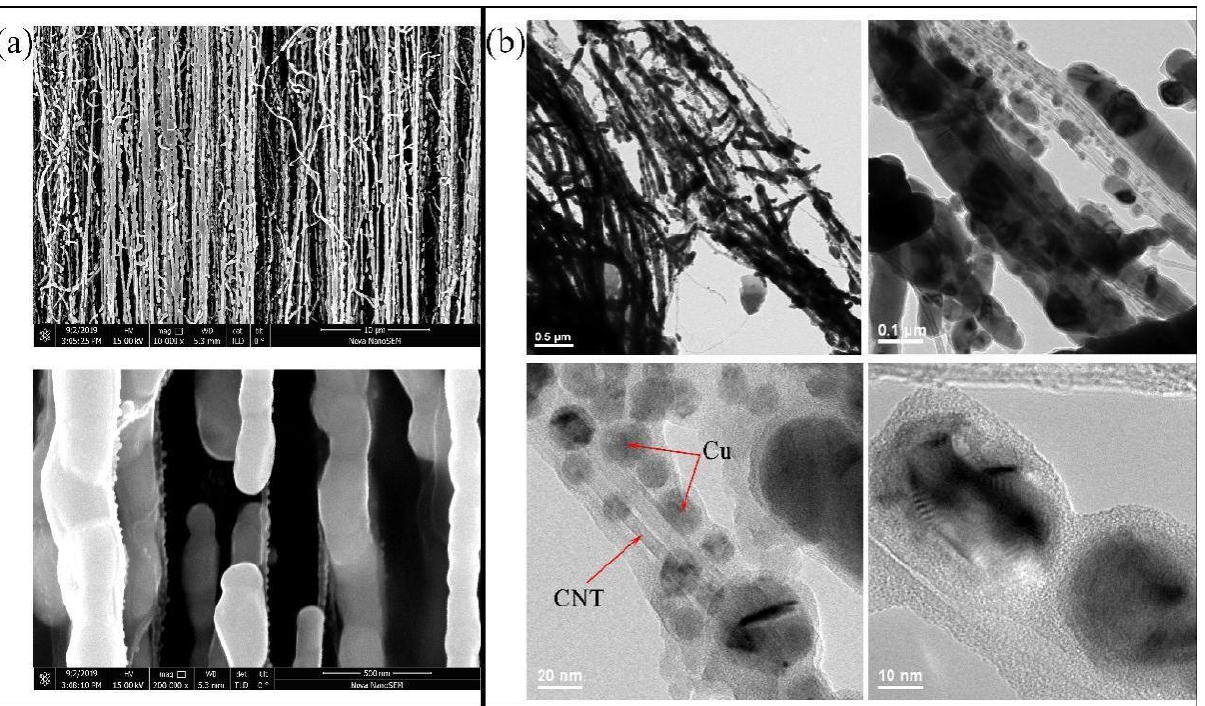
Figure 3. The images of Cu growth on SACNT at the initial stage, ( a ) scanning electron microscope (SEM) and ( b ) TEM.